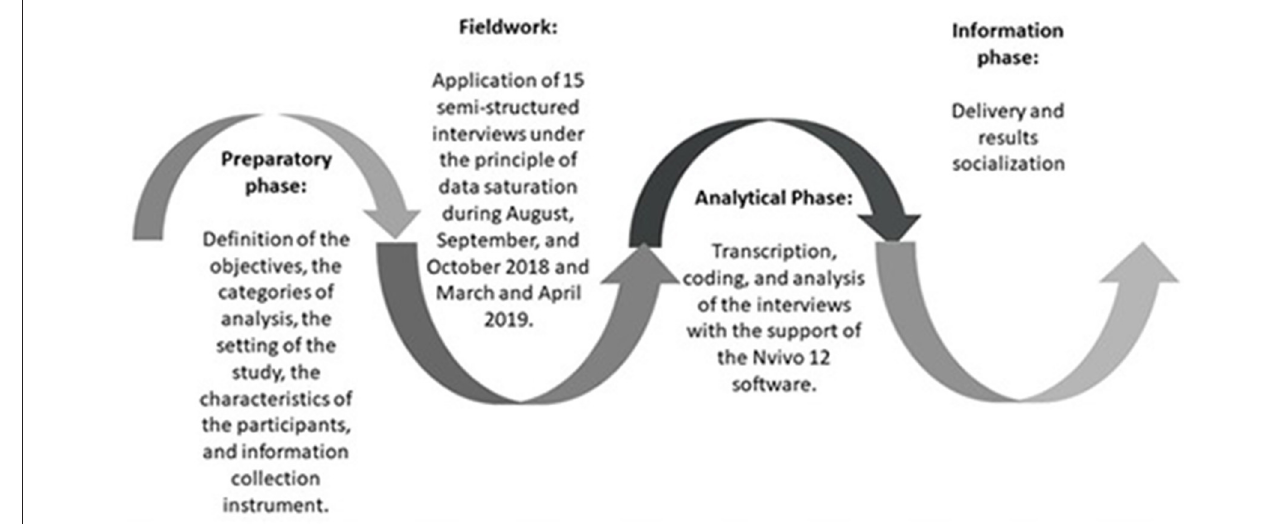
FIGURE 1 | Phases of the